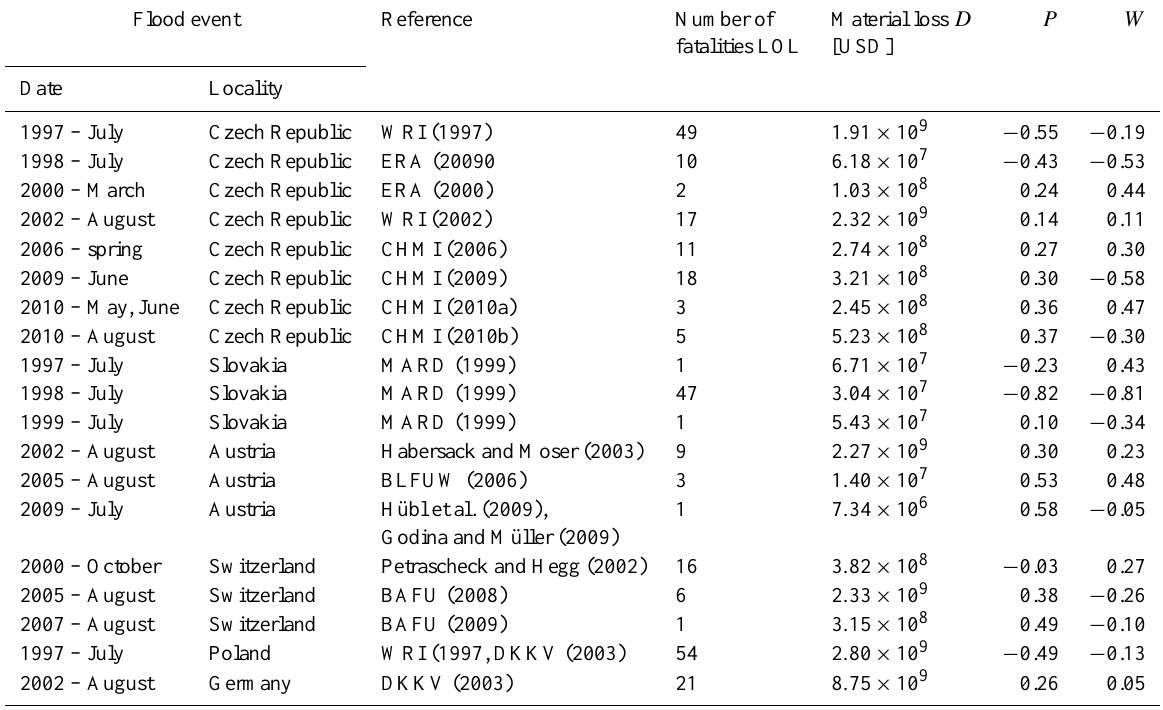
Table 5. Data related to real flood events used for the calibration of the loss of life model. Flood